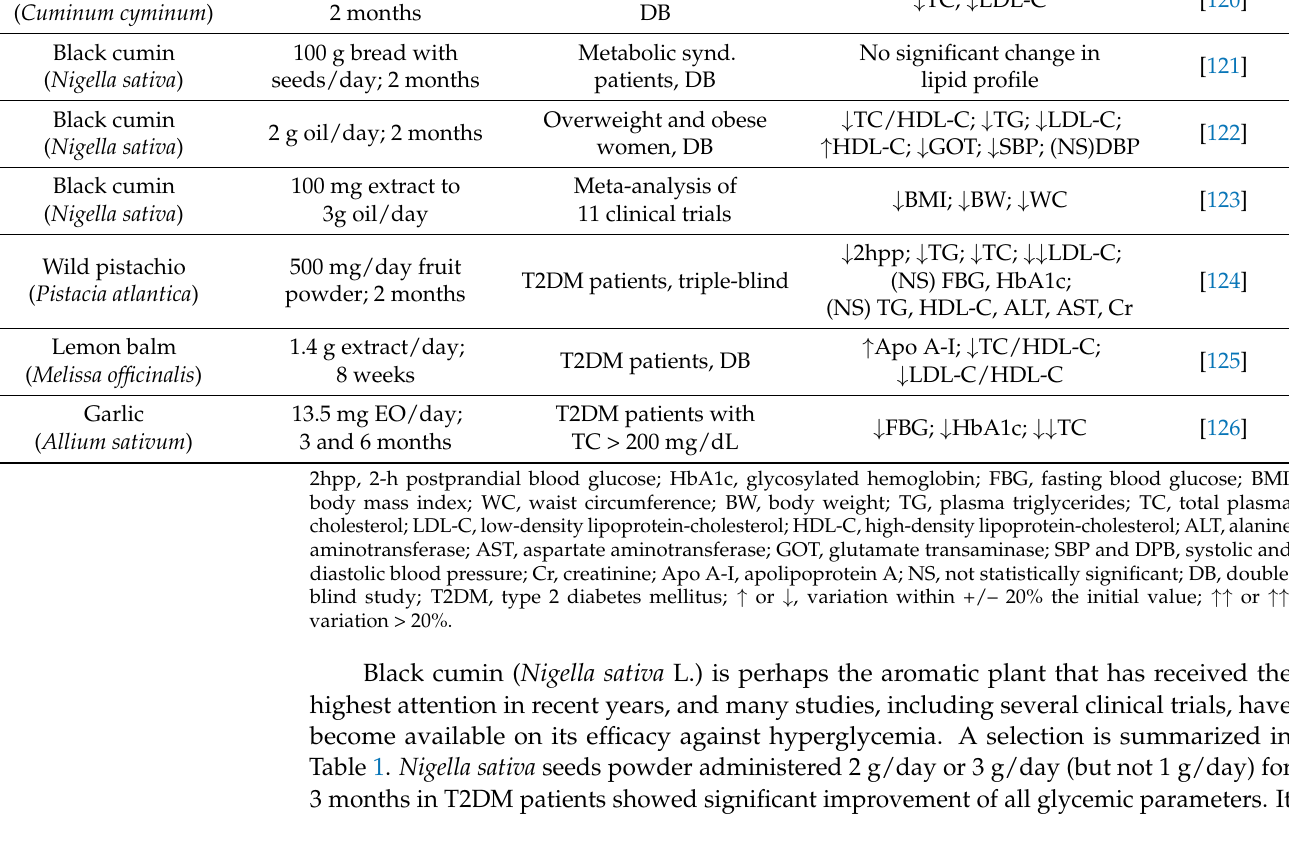
Table 1. Nigella sativa seeds powder administered 2 g/day or 3 g/day (but not 1 g/day)